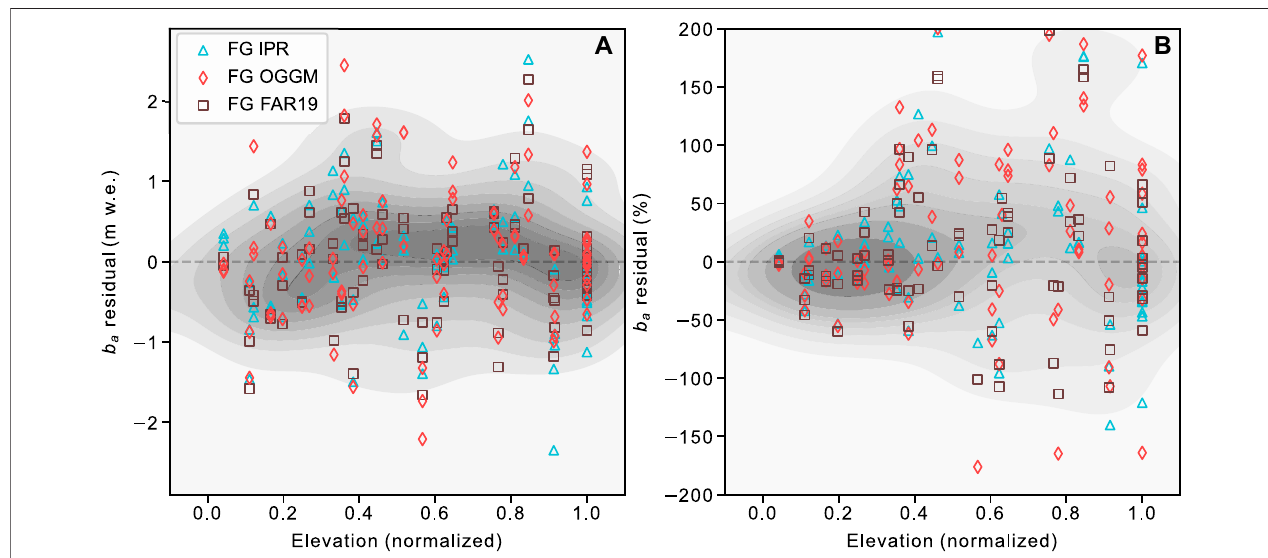
FIGURE10| Mass-balanceresiduals(observed — modeled)for fl uxbinsagainstnormalized elevationforConrad,Illecillewaet, andKokaneeglaciers.Residualsare expressed as (A) netresiduals,and (B) percentresiduals. Allpointsareused forthekerneldensity estimationplot(grey)whichrepresentstheprobabilitydistribution asa non-parametric estimatorofdensity.For (B) ,40largeresiduals > ± 200%arenotshowntobetterdisplaythespreadofmostresiduals( n (cid:3) 294).Theseomittedpercent residuals are predominately near the ELA, with a median normalized elevation of 0.75. The net magnitude of residuals is independent of elevation, but the percent residuals grow with increasing elevation as the net magnitude of mass balance decreases near and above the ELA relative to the lower elevations ( Figure 8 ).